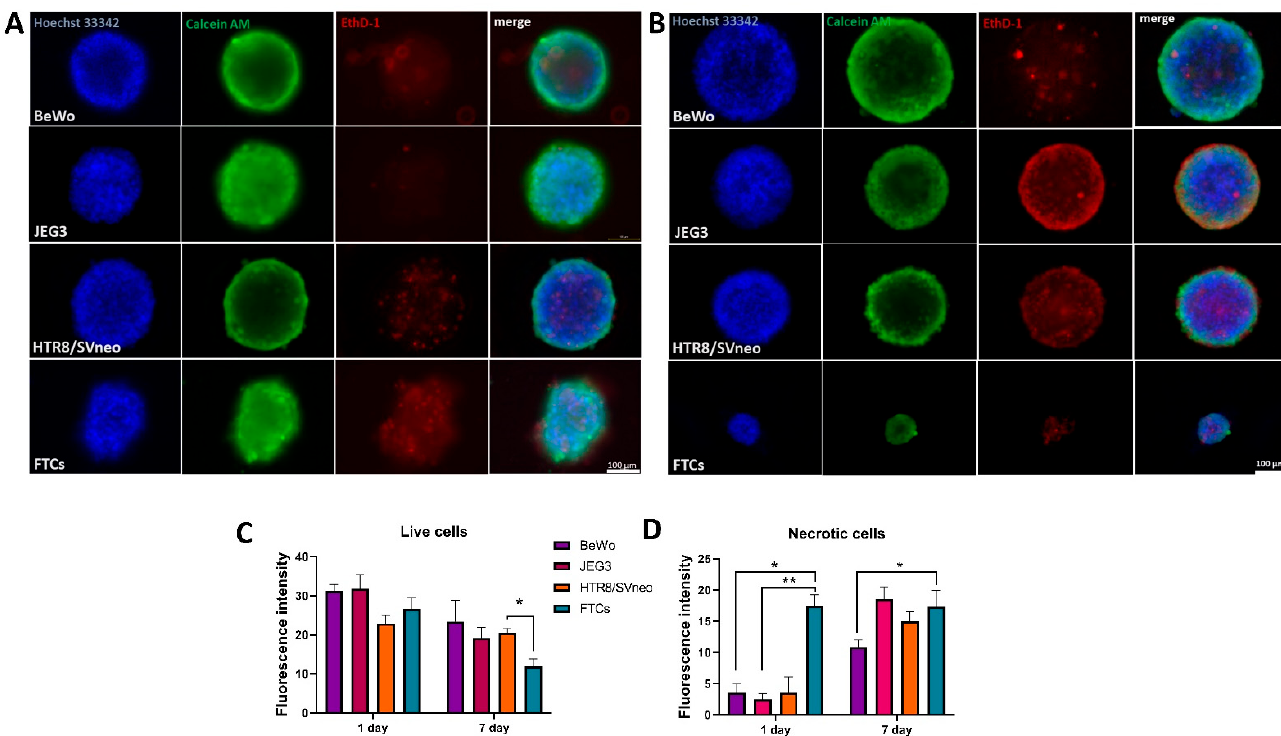
Figure 2. Viability prevalence in trophoblast spheroids. Fluorescent images at day 1 ( A ) and day 7 ( B ) showing metabolically active cells with Calcein AM staining (green) and necrotic cells with Ethidium Dimer (red). Nuclei are stained with Hoechst 33342 (blue). Fluorescence intensities of live and metabolically active ( C ) and necrotic ( D ) cells. Scale bar 100 µm. * p < 0.05; ** p < 0.01.